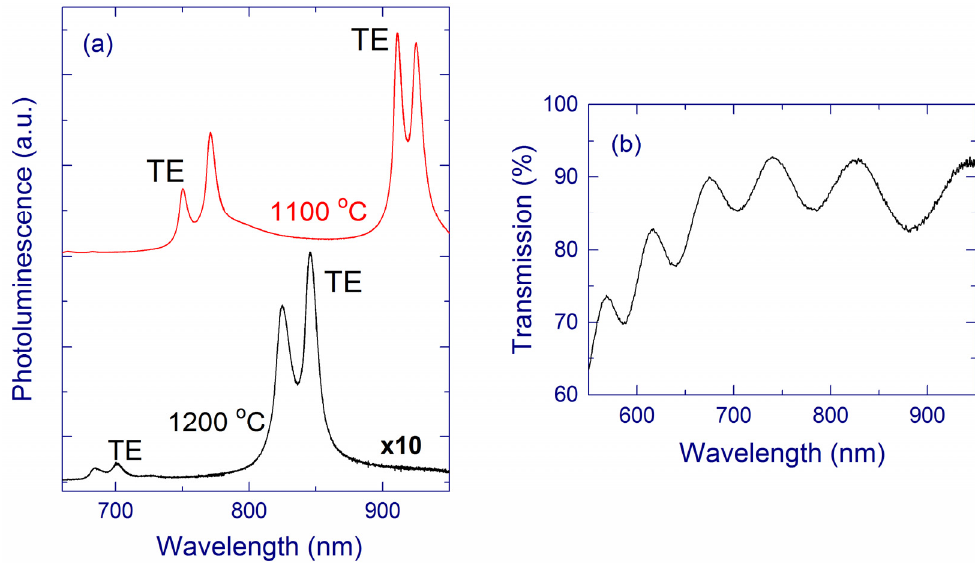
Figure 20. ( a ) Cut-off spectra of a SiO 1.5 film annealed at 1100 and 1200 °C, measured from the sample edge along the film. The excitation spot was at a distance of several millimeters from the sample edge. The positions of the TE peaks are marked and the other bands have the TM polarization. The TE and TM peaks have polarization parallel and perpendicular to the film surface, respectively. ( b ) Transmission spectrum of the SiO